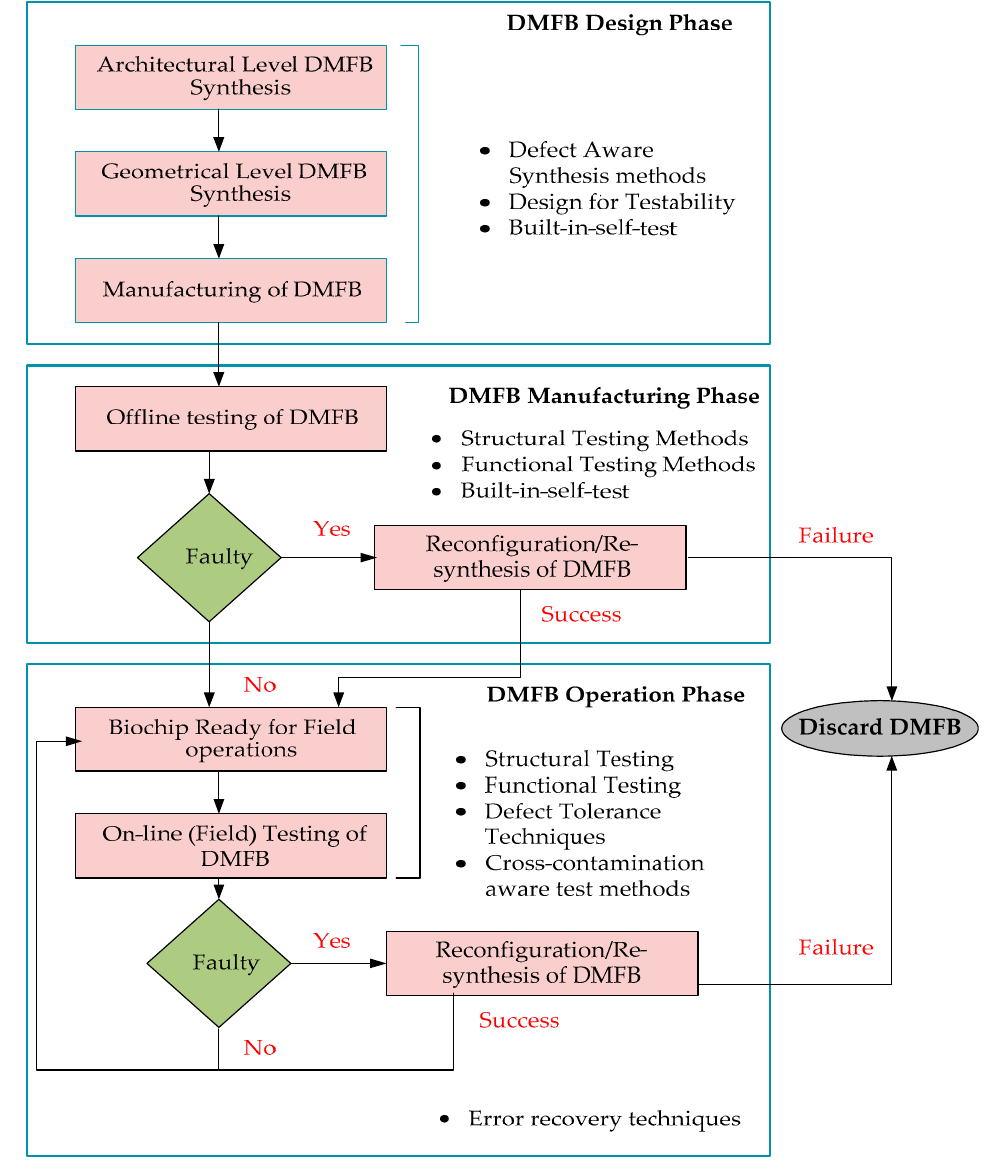
Figure 2. Design flow and test of Digital Microfluidic Biochips.